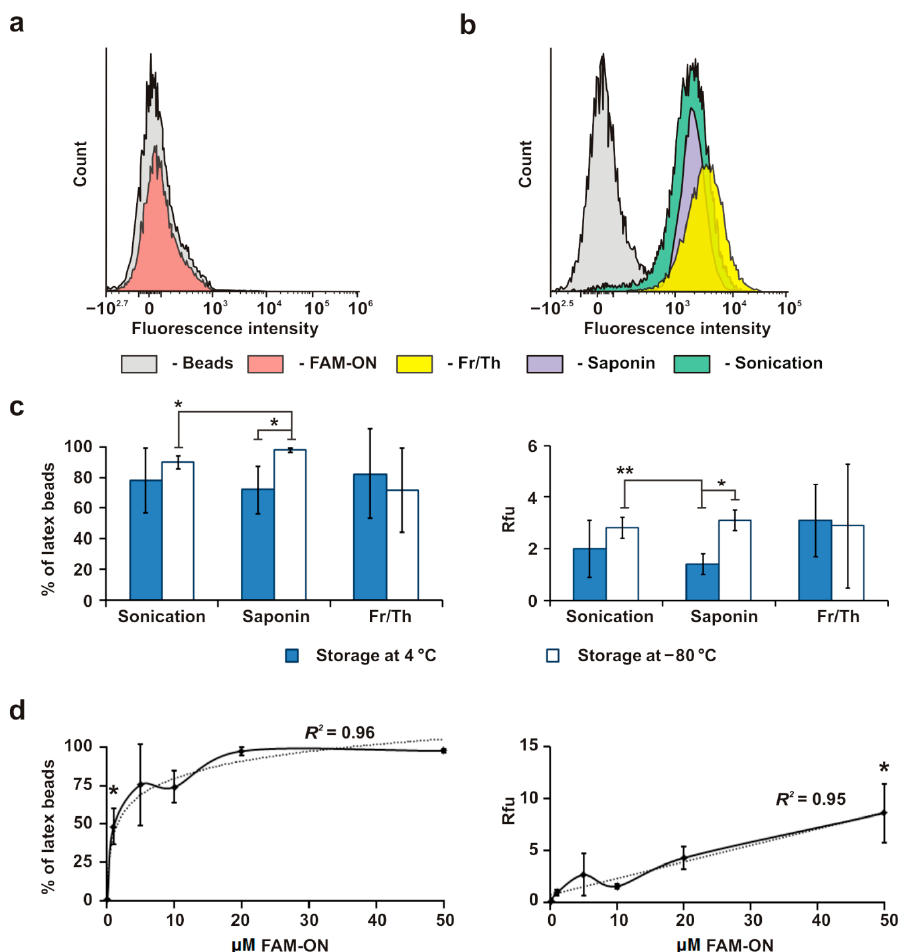
Figure 2. MSC-derived EV loading with FAM-ON, performed by Fr / Th, permeabilization with saponin or sonication. Flow cytometry analysis was used. ( a ) Control, non-specific binding of FAM-ON with latex beads in the absence of EVs. ( b , c ) Flow cytometry analysis of EV loaded under standard conditions (15 µ g EVs and 1 nmol FAM-ON in 200 µ L TBS) performed by Fr / Th, saponin treatment, or sonication. ( d ) E ff ect of FAM-ON concentration on the e ffi ciency of EV loading by Fr / Th. Data are presented as the mean ± standard deviation; the dotted line shows the theoretical curve. All experiments were performed in TBS. Statistical analysis was performed with the Mann–Whitney U test; * p ≤ 0.05, ** p < 0.05, *** p ≤